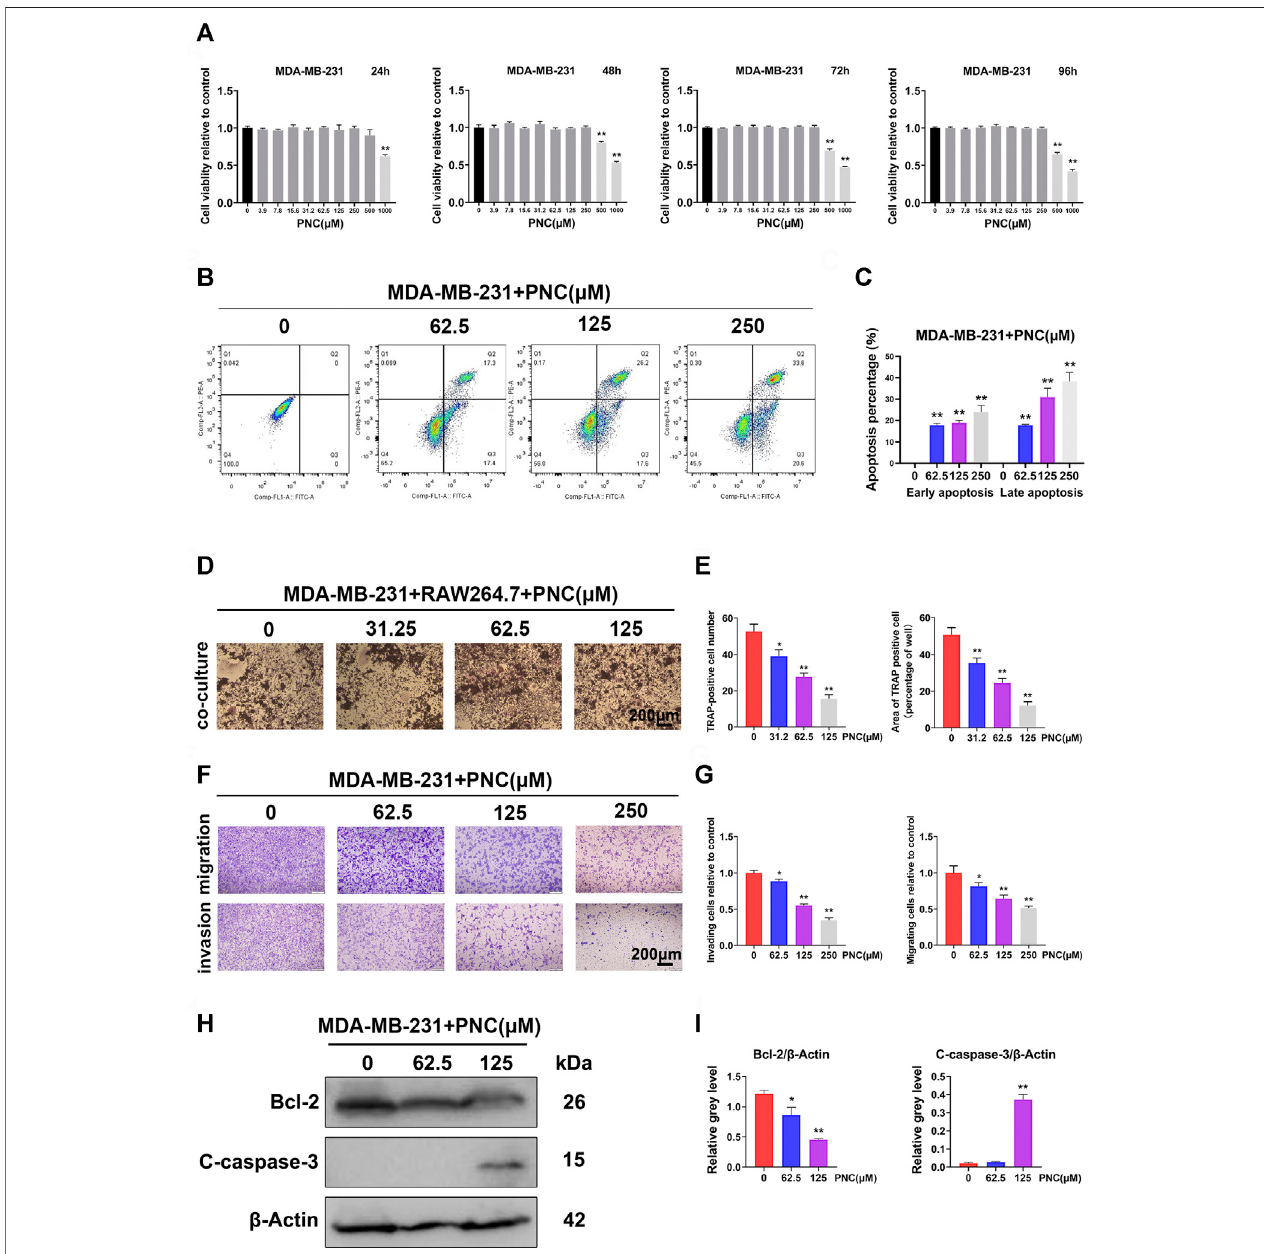
FIGURE 5 | Nontoxic PNC suppressed human breast cancer MBA-MD-231 cell-induced osteoclastogenesis, promoted apoptosis of MBA-MD-231 cells, and inhibited the migration as well as invasion of MBA-MD-231 cells in vitro . (A) Viability of MBA-MD-231 cells after PNC treatments for 24 – 96 h ( n (cid:1) 3). (B) Flow cytometric analysis of apoptotic breast cancer cells with PNC treatment. (C) Quanti fi cation of the percentage of apoptotic MDA-MB-231 cells after treatment with diverse concentrations of PNC (0, 62.5, 125,250 μ M) for 48 h ( n (cid:1) 3). (D) RAW 264.7 cells cocultured with MDA-MB-231 cells, treated with PNC, and cocultured for 1 week before TRAP staining. (E) Quantitative analysis of TRAP positive osteoclasts ( n (cid:1) 3). (F) Ef fi cacy of PNC on the suppression of migration as well as invasion of MDA-MB-231 cells. The irregularly shaped cells, that invaded and migrated, showing purple staining were counted and photographed. (G) Quanti fi cation of the percentage of cell invasion and migration by ImageJ software. Bars represent the SD, whereas columns represent the means ( n (cid:1) 3). (H) After the PNC-treated MDA- MB-231cellswereculturedfor2 days,PNC-inducedcleavedcaspase-3andBcl-2levelswereexaminedusingWesternblotting. (I) Averageratiosofcleavedcaspase-3 as well as Bcl-2 relative to β -actin. ** p < 0.05, ** p < 0.01, when compared to the control group.